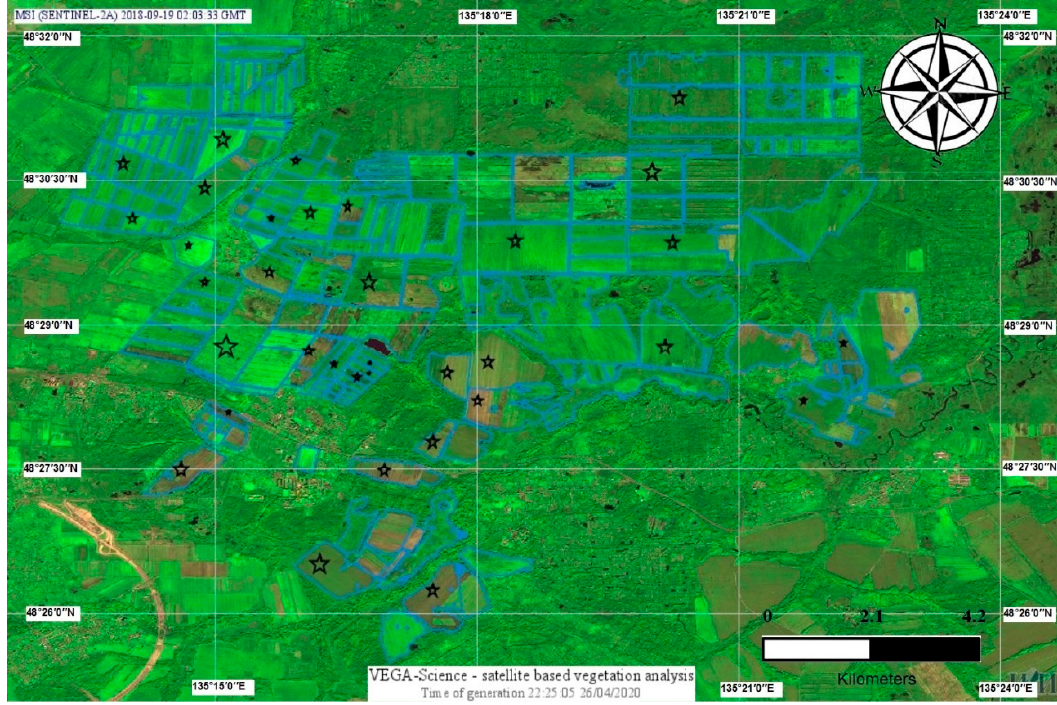
Figure 2. Fields of the Far East Research Institute of Agriculture.